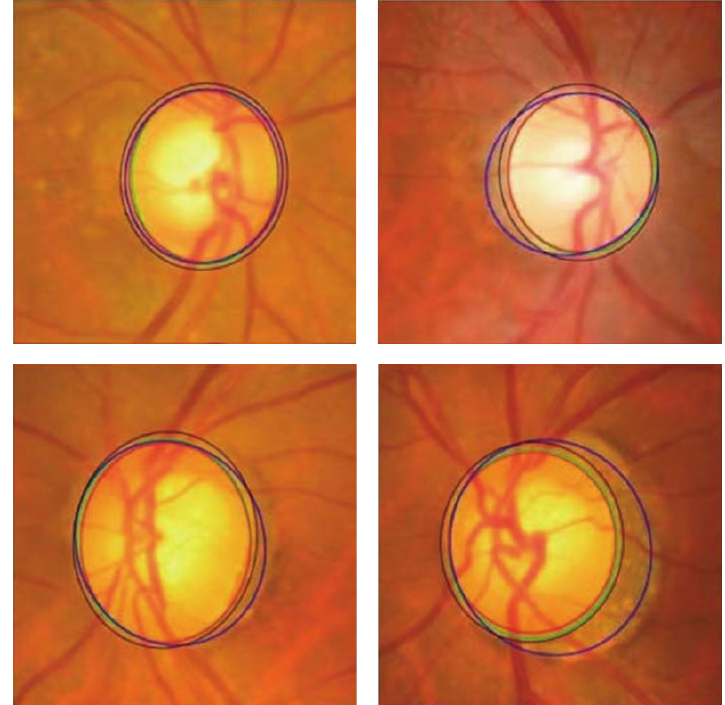
Figure 28: OD segmentation using proposed method (red), level set method (blue), and FCM method (black) with ground truth (green).